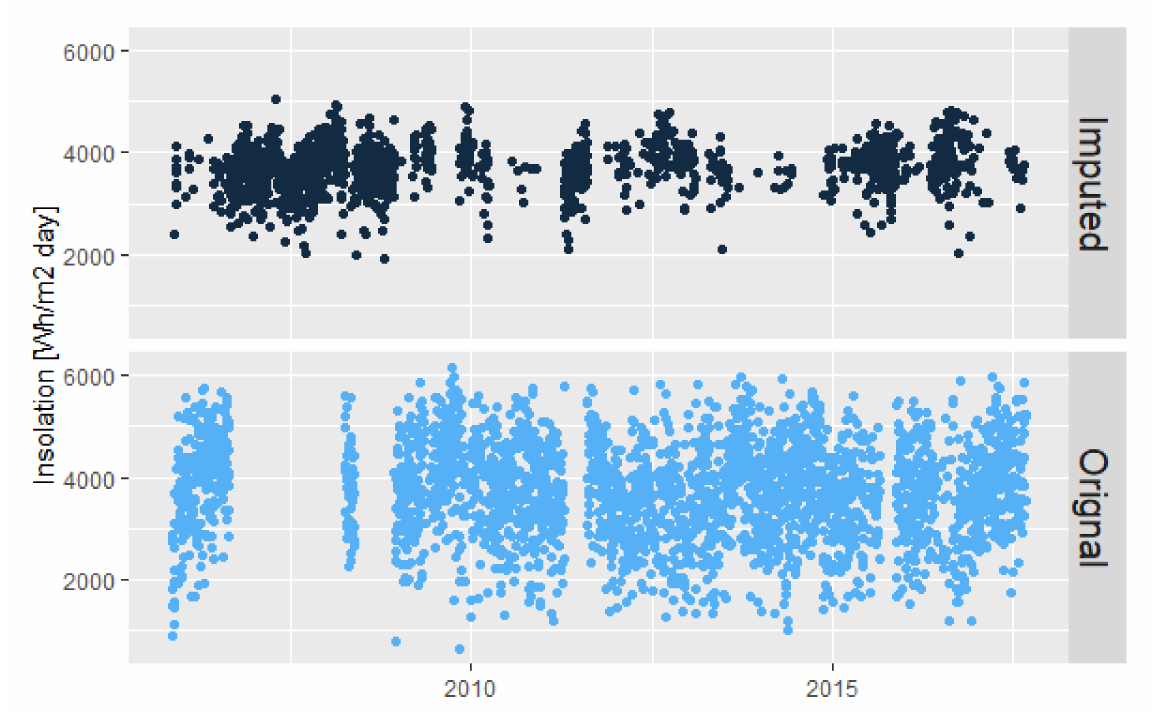
Figure 13. Viento Libre imputation.